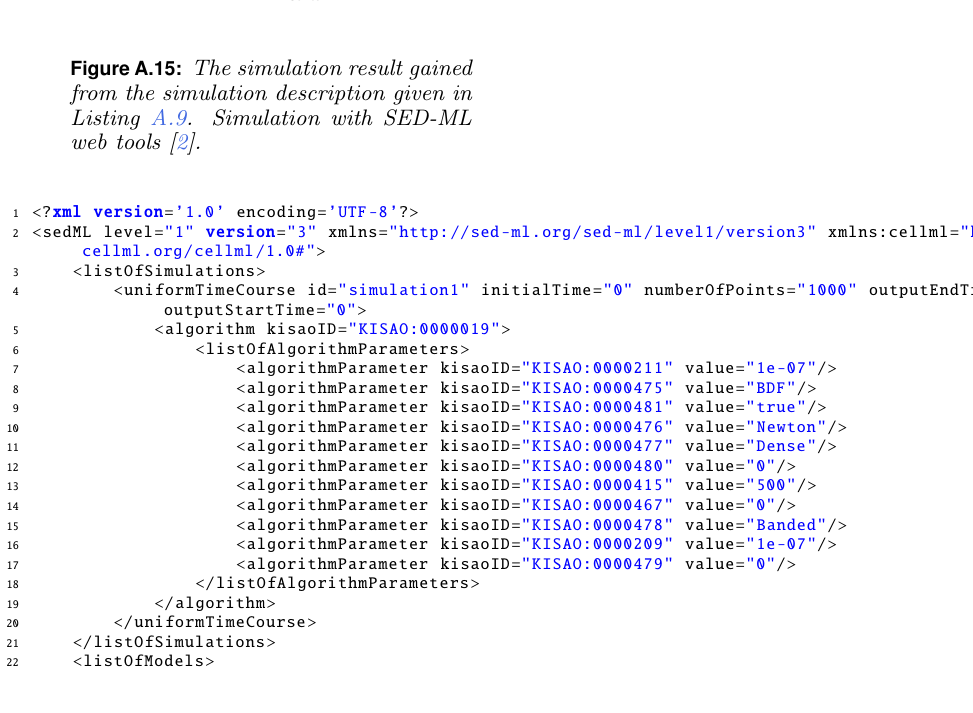
Figure A.16: Simulation with OpenCOR